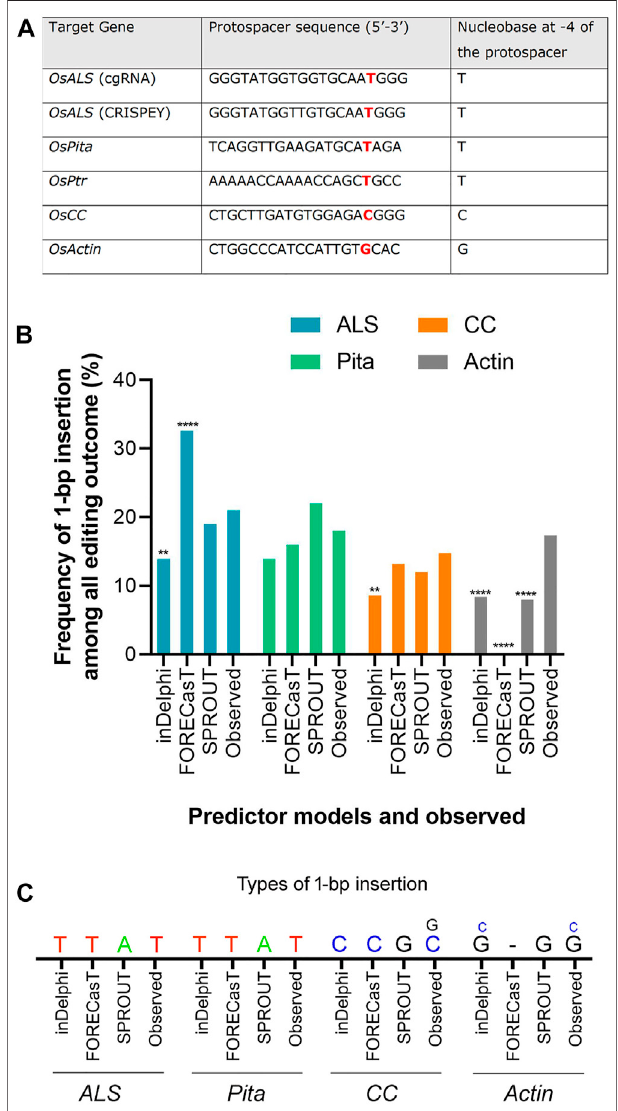
FIGURE 3 | Prediction of 1-bp insertion using models. (A) Protospacer sequences used in the study. ALS protospacers for Jupiter (used in cgRNA) and Kitaake (used in CRISPEY) are differed by a single nucleotide. (B) Frequency of 1-bp insertion predicted by inDelphi, FORECasT, and SPROUT versus observed frequency. Each prediction data was compared with the observed data. For ALS , CC , and Actin loci, deep sequencing data was treated as observed data. Observed data for Pita derived from Sanger sequencing.(**)denotes p ≤ 0.01;(****)denotes p ≤ 0.0001. (C) Typesof1-bp insertion predicted and observed across four loci. Smaller letters indicate second most prevalent